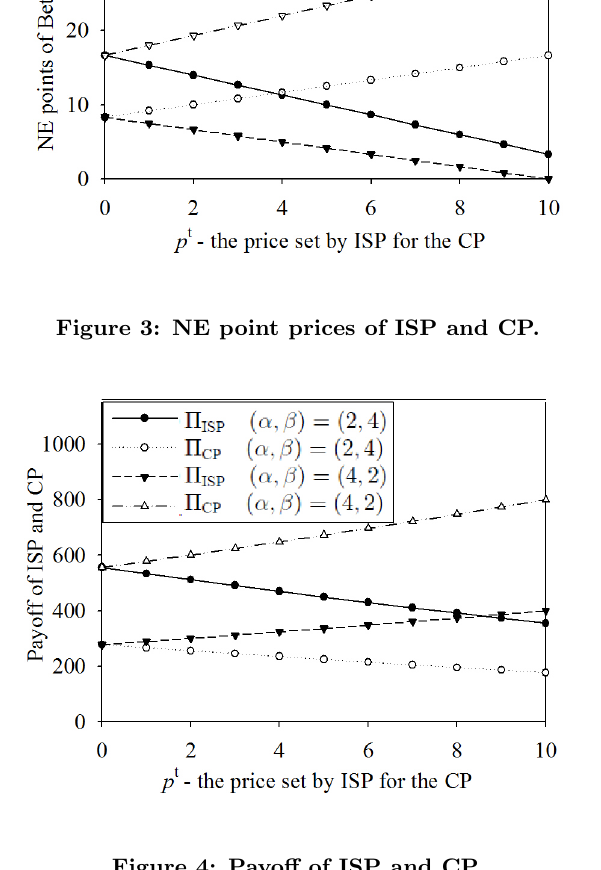
Figure 4: Payoff of ISP and CP.